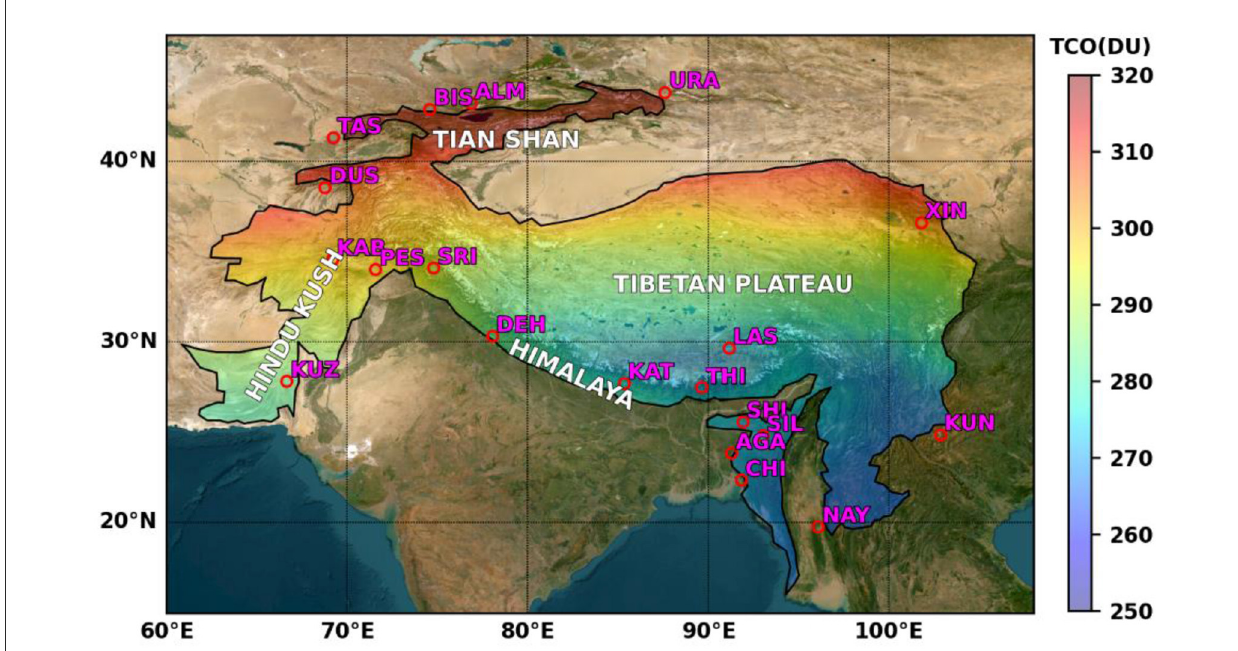
FIGURE1 Third Pole and the adjacent cities in the region. The annual mean TCO (DU) averaged over the period 2005–2020 is shown. The city name, latitude, longitude, and elevation are given in Table 1.